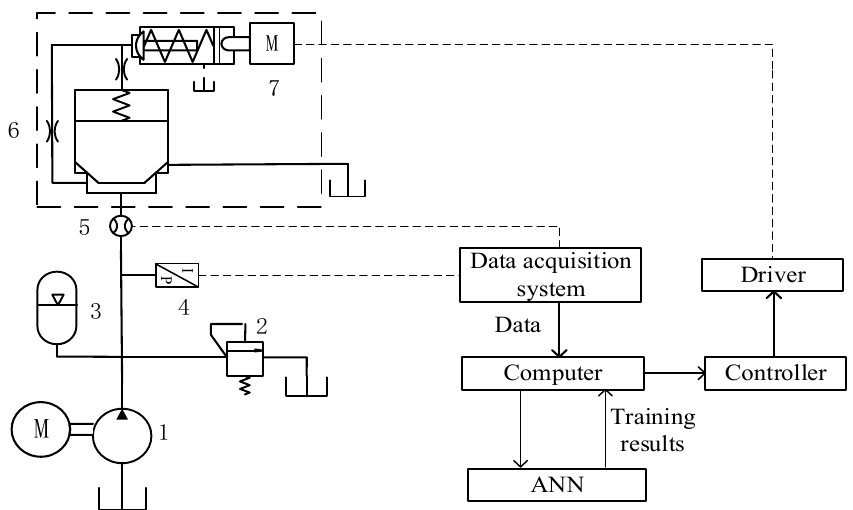
Figure 8. Schematic of digital relief valve-based emulsion pump testing system. 1—Pump being tested; 2—safety valve; 3—accumulator; 4—pressure sensor; 5—flow sensor; 6—digital relief valve; 7—linear stepper motor.